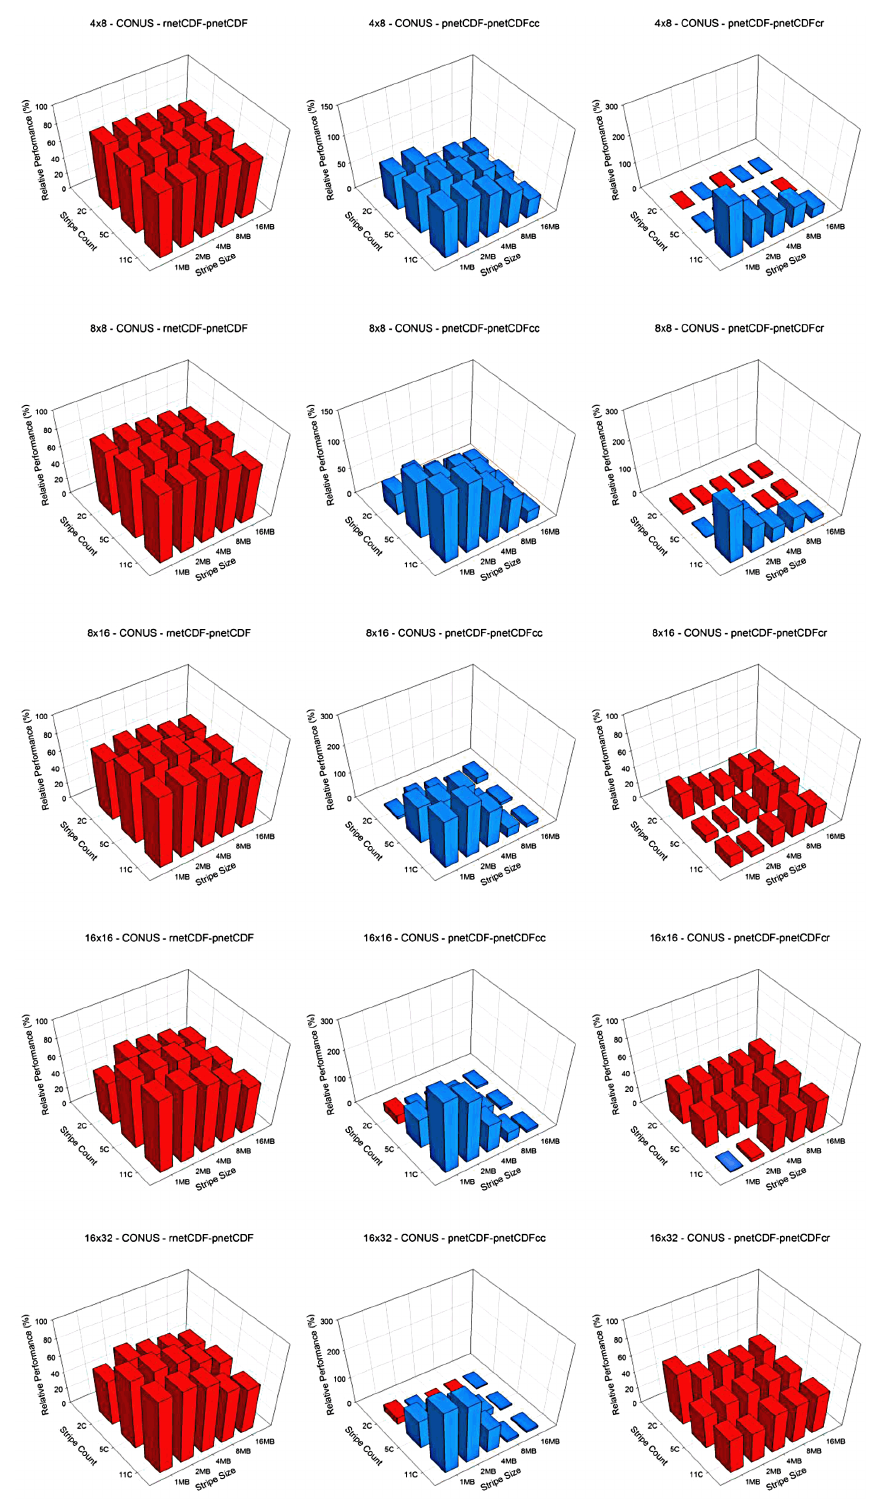
Figure 8. Relative I/O performance of pnetCDF to rnetCDF, and pnetCDFcc and pnetCDFcr to pnetCDF on the CONUS domain with 4 × 8, 8 × 8, 8 × 16, 16 × 16, and 16 × 32 processor configurations from Edison. Red color denotes positive value in relative performance while blue color denotes negative value in relative